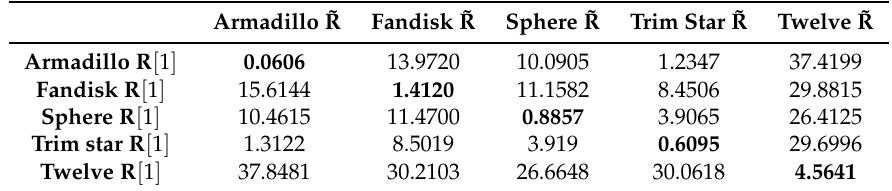
Figure 6. Laplacian matrices of different submeshes for different models in color based on the values of their cells. It can be easily observed that different submeshes of the same model follow a similar form while they are totally different in comparison with submeshes of different meshes. Table 1. Mean squared error between the R [ 1 ] of different models and the mean ˜R of each model. The lowest value per row is highlighted in